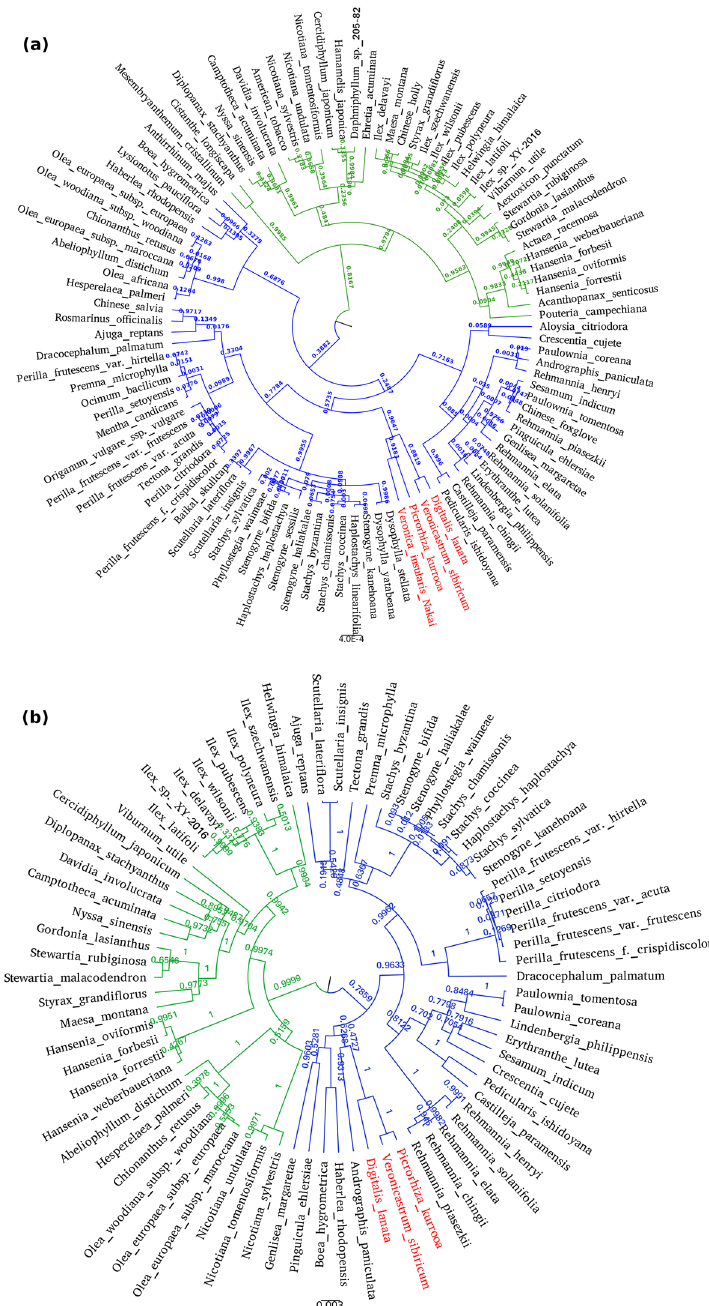
Figure 4. ( a ) Phylogenetic tree on the basis of ribosomal RNA, showing 100 different taxons on the nodes and posterior probability onto branches. Two major clusters with blue and green colors on branches are showing major classification of Lamiales (blue color), other orders are depicted in green color. Red color taxon represents small cluster of P. kurrooa with other members of Veroniceae tribe along with Digitalis lanata. ( b ) Phylogenetic tree with 74 species obtained on the basis of a chloroplast gene. This tree was found strongly in concordance with the one obtained through ribosomal RNA